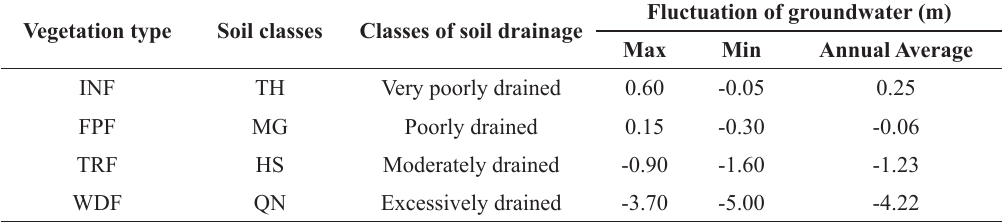
Soil classes and groundwater fluctuation in the four forests of Jacarenema Natural Municipal Park, Vila Velha, Brazil. INF=Inundated Forest; FPF=Floodplain Forest; TRF=Transitional Forest; WDF=Well-drained Forest. TH=Thiomorphic Histosols; MG=Melanic Gleysols; HS=Humic Spodosols; QN= Quartzarenic